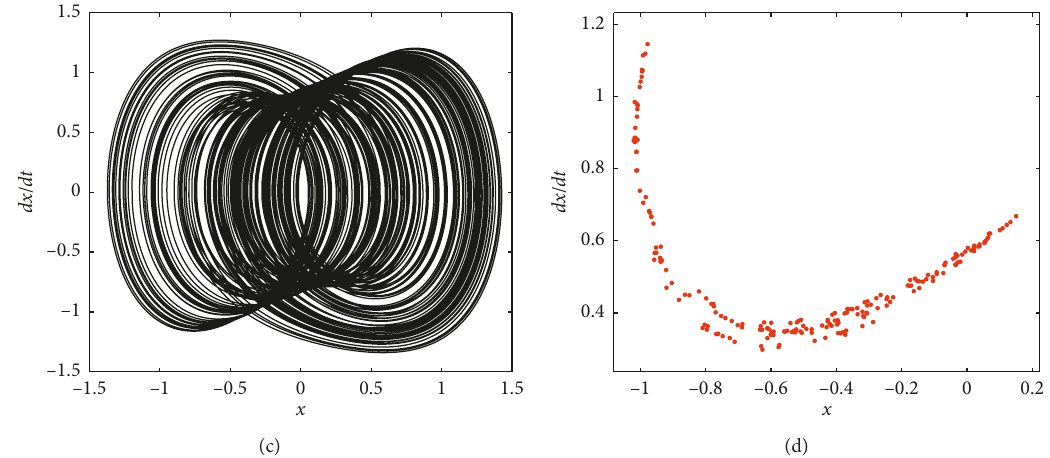
Figure 15: System response at ω � 1.5rad/s and F � 1.5 N: (a) time history; (b) frequency spectrogram; (c) phase portrait; (d) Poincare maps. Table 1: System responses for different typical points ( F � 1N). Excitation frequency The largest Lyapunov Points (rad/s)